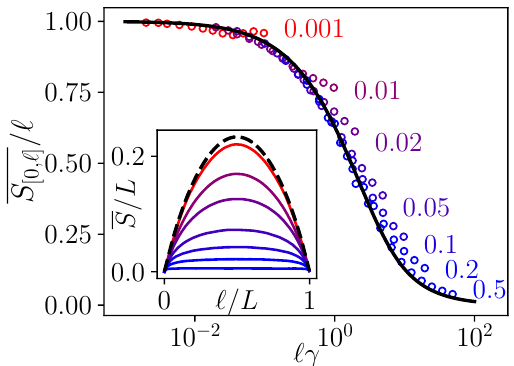
Figure 4: Averaged EE in the stationary regime on [ 0, (cid:96) ] in a system of size L = 512 and filling factor n = 1 , with varying measurement rate 2 γ = 0.001,0.01,0.02,0.05,0.1,0.2,0.5 (from red to blue, indicated besides each data set). The main plot collapses the numerical data (in circles) according to the scaling relation (32), which is satisfied as long as 1 (cid:28) (cid:96) (cid:28) L . The prediction (32) is plotted in thick curve. The inset shows the raw data (plotted in solid curves with the same color codes), compared to the γ = 0 case drawn with thick dashed